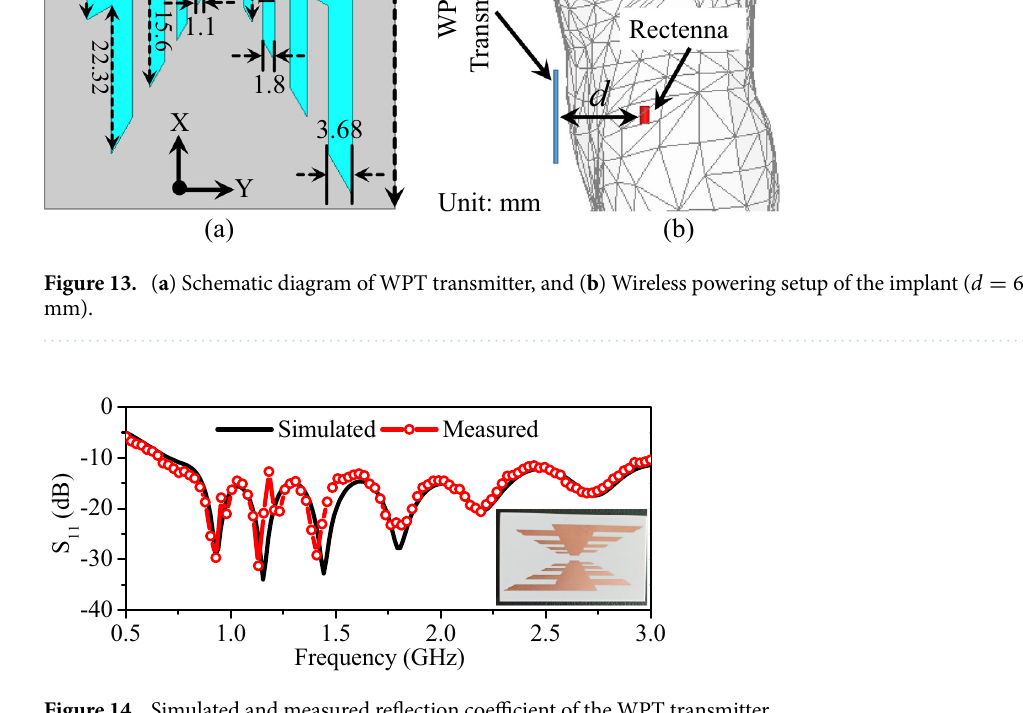
Figure 14. Simulated and measured reflection coefficient of the WPT